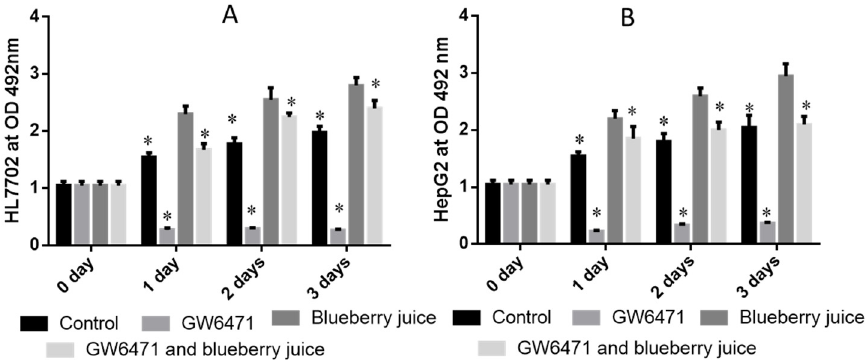
Figure 3. The activity of PPAR ‐α in different cells: ( A ) the effects of BP on the antagonist of PPAR ‐α in HL7702 cells; and ( B ) the effects of BP on the antagonist of PPAR ‐α in HepG2 cells. Five samples were analyzed in each group. All data are presented as mean value ± S.D. * p < 0.05 via a blueberry juice group BG.